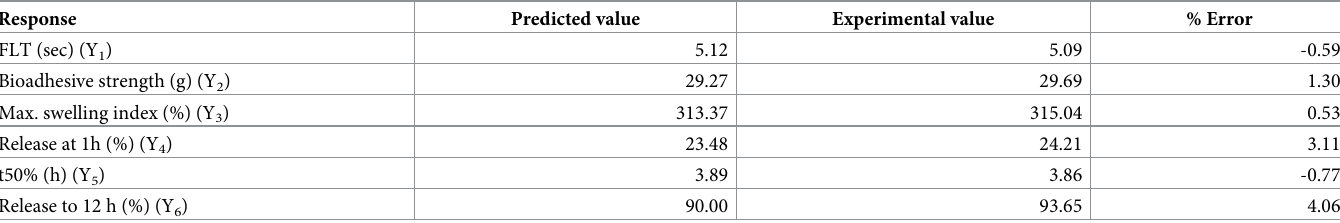
Table 6. Response values of predicted, experimental and percentage error obtained at optimal levels of the